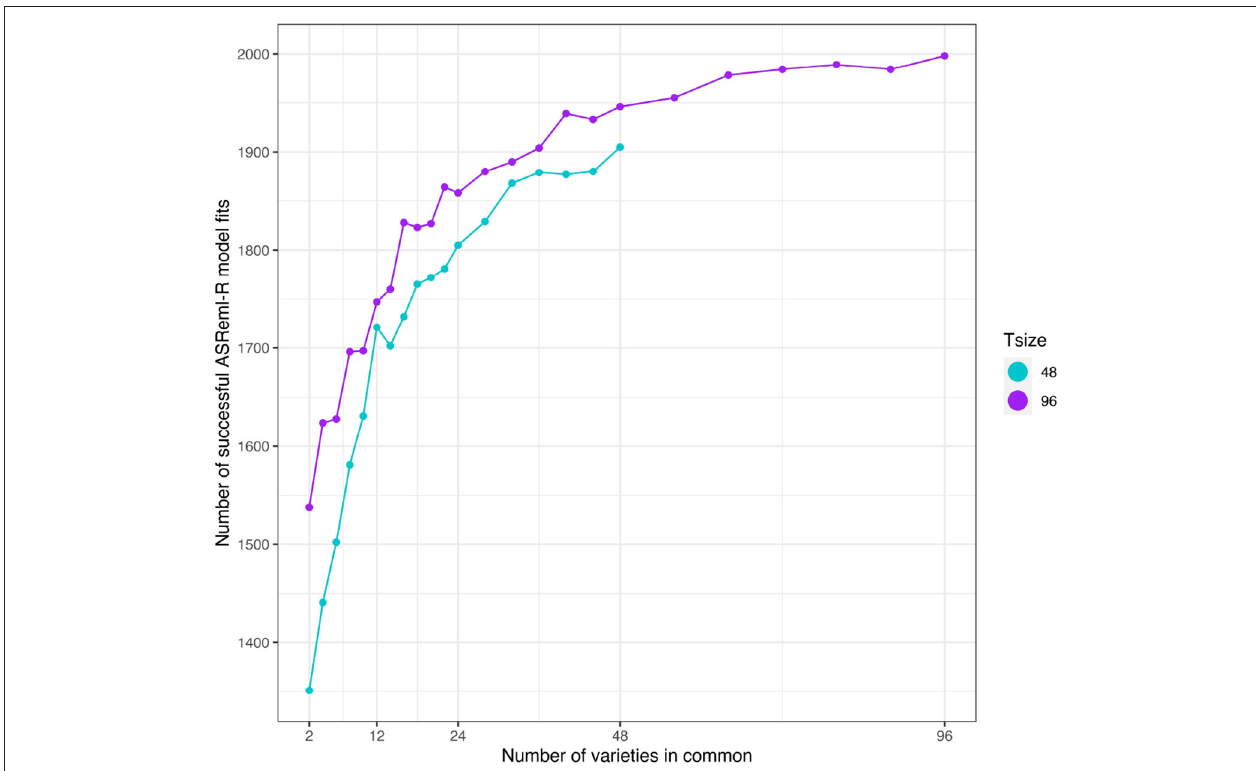
FIGURE 8 | Additive VE effects simulation study: Number of successful model fits from N = 2,000 simulations plotted against number of varieties in common for two trial sizes (trials with 48 and 96 varieties). Trial sizes (Tsize) are represented using different colours. Each point within Tsize corresponds to a different level of variety connectivity which ranges from c = 2 up to the number of varieties in a trial (representing 100% connectivity between the two trials).